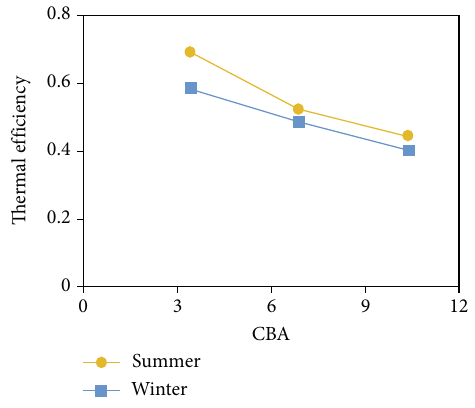
Summer Figure 12: E ff ect of CBA on the thermal e ffi ciency